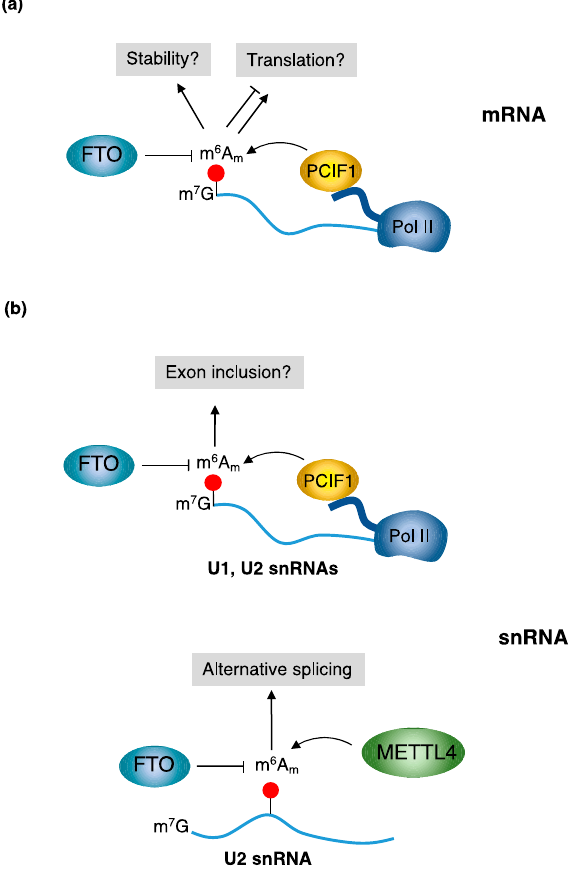
Figure 3. Regulators of m 6 A m modification. ( a ) PCIF1 methylates the first transcribed 2 ′ -O-methyladenosines, when present, producing m 6 A m during primary mRNA transcription. This modification can be removed in the cytoplasm by FTO demethylases. The consequences of cap m 6 A m deletion are still under debate. It was reported that m 6 A m can increase mRNA translation, decrease mRNA translation, increase mRNA stability, and not affect mRNA stability (see main text for details). ( b ) Different snRNAs, including U1 and U2, contain m 6 A m on their caps and this methylation is established by PCIF1 and removed by FTO. In addition, the U2 snRNA contains an internal m 6 A m site that is installed by METTL4 and whose deletion causes altered alternative splicing.